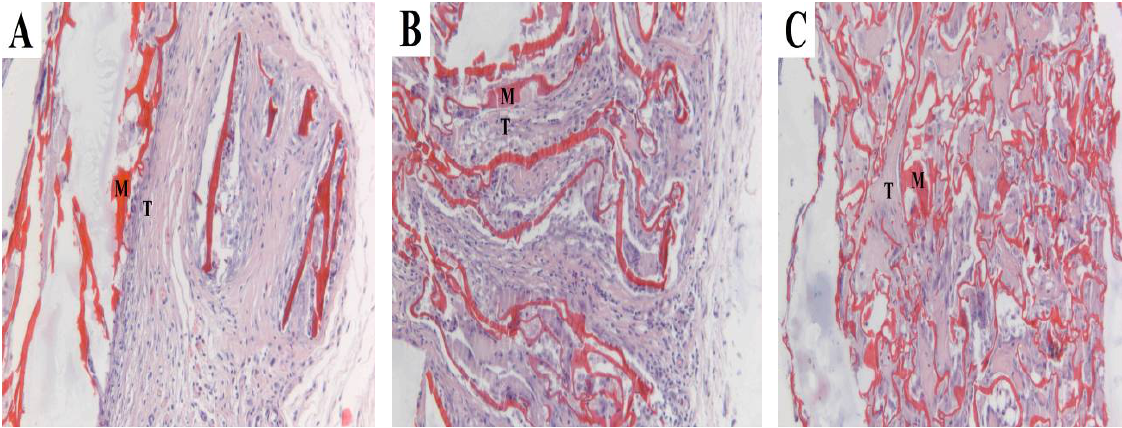
Figure 9. Histological sections of CS, PCLA and PLA scaffolds after 8 weeks of implantation ( A ) CS; ( B ) PCLA- Ι ; ( C ) PCLA- ΙΙ ; ( D ) PCLA- ΙΙΙ ; ( E ) PLA.M stand for materials and T stand for tissues